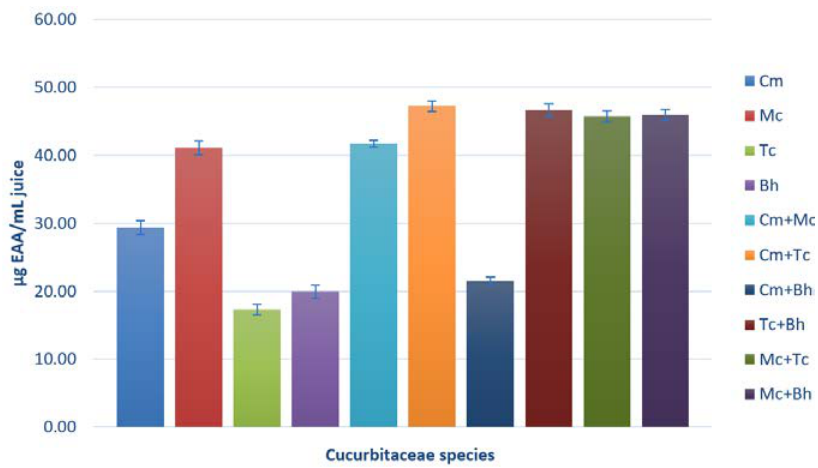
Figure 8. TAC assay; where Cm- C.metuliferus, Tc- T. cucumerina , Mc- M. charantia, Bh- B. hispida, AA-ascorbic acid. The error bars represent ± standard deviation of three replicates.